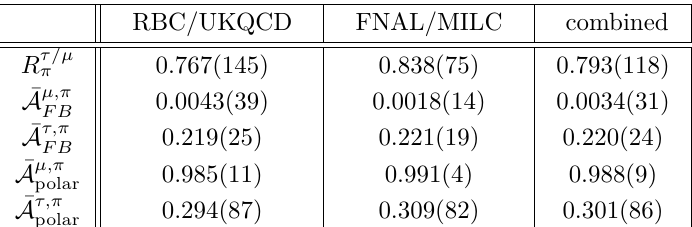
Table 5 . The theoretical values of the quantities (4.1)–(4.3) in the case of the semileptonic B → π‘ν ‘ decays with ‘ = µ, τ adopting the RBC/UKQCD, the FNAL/MILC and the combined LQCD data of table 1 as inputs for our DM method.